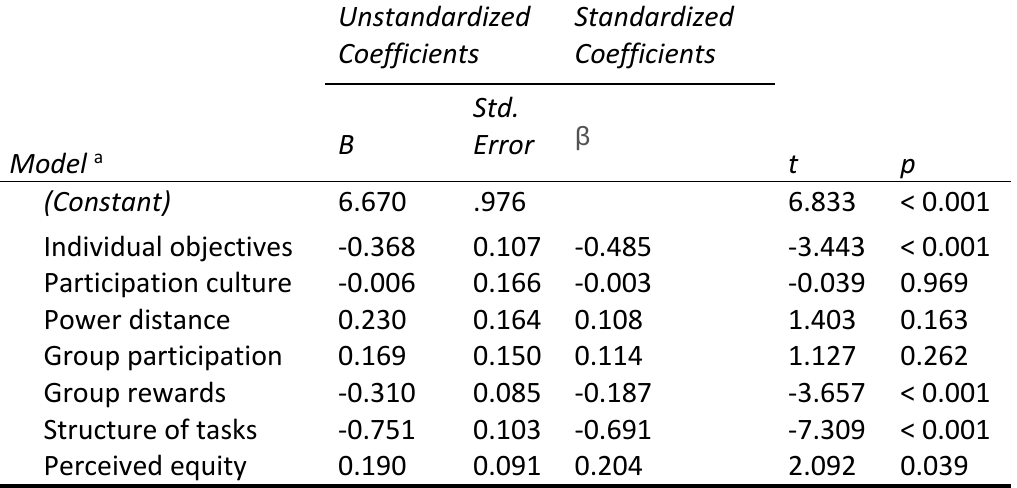
Group Cohesion Regressed on Seven